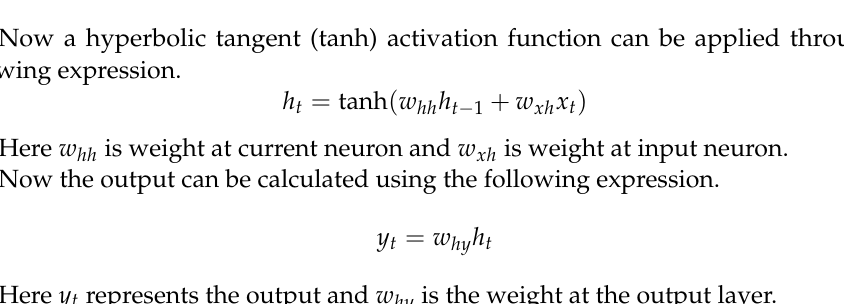
Figure 9. A general architecture of the Recurrent Neural Network